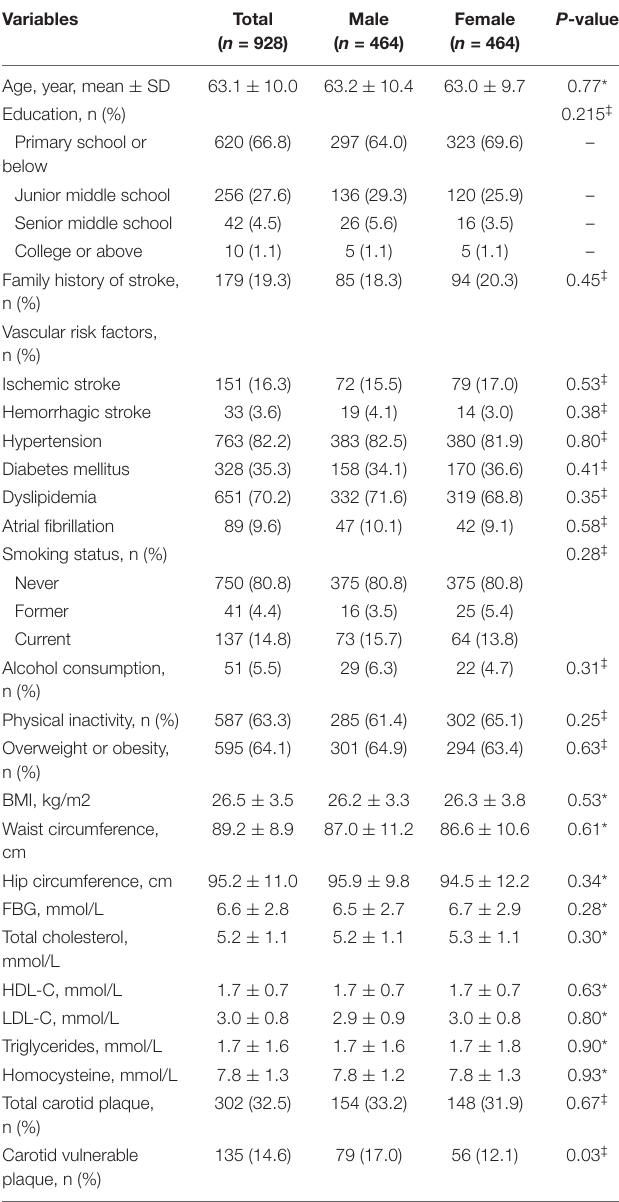
TABLE 4 | Gender differences in the characteristics of individuals at high risk of stroke and the prevalence of carotid plaque after PSM. Variables Total